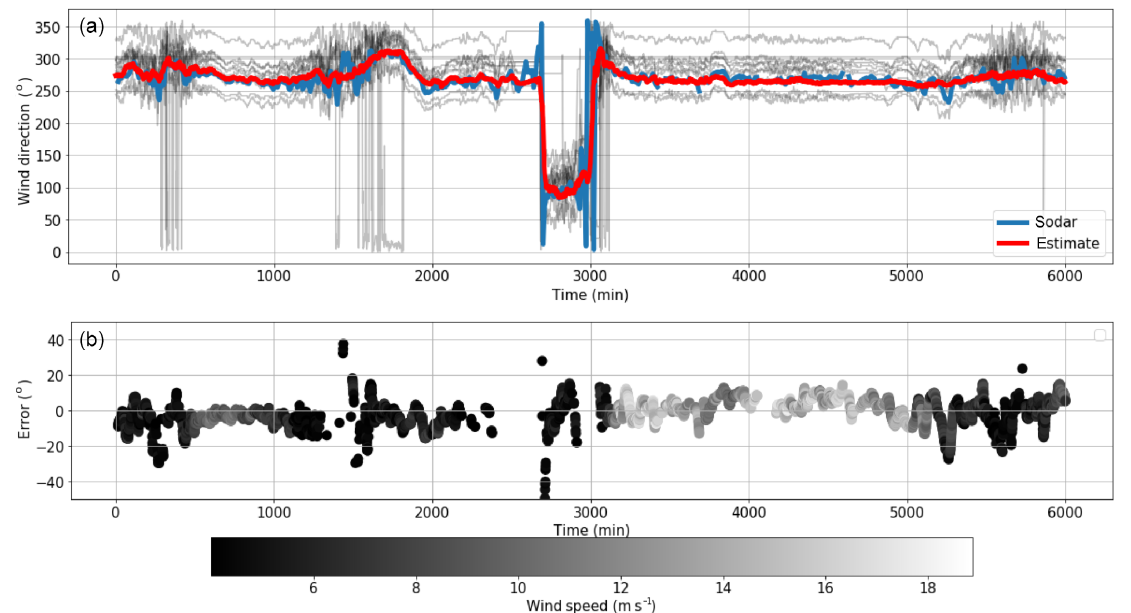
Figure 9. (a) Comparison between the estimated wind direction calculated via consensus at the location of the sodar (red) and the actual wind direction recorded by the sodar (blue). The wind directions recorded by the nearest 10 turbines are shown in gray. (b) Error between the estimate and the actual wind direction recorded at the sodar. The dots are color-coded based on wind speed.